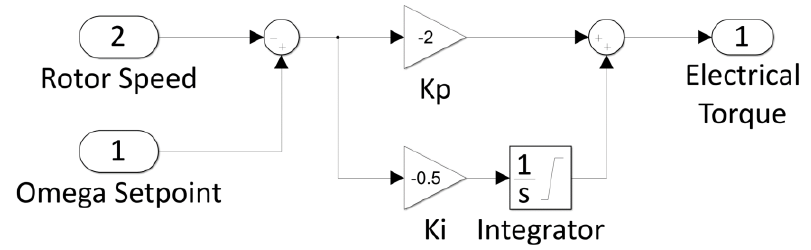
Figure 15. Detail of the PI regulator.